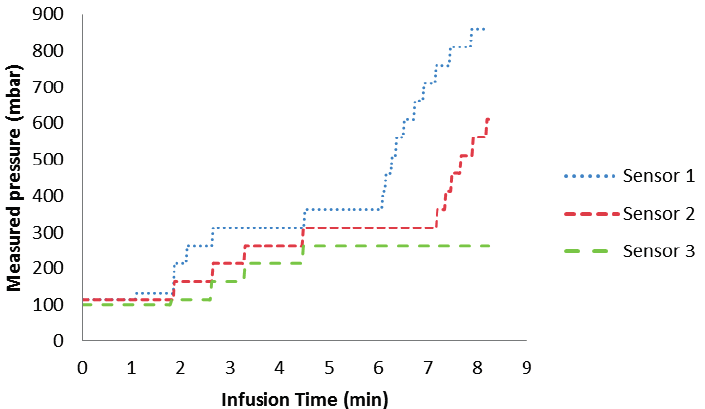
Figure 9. Measured pressures by the embedded PPSs in glass fiber laminate during infusion time.